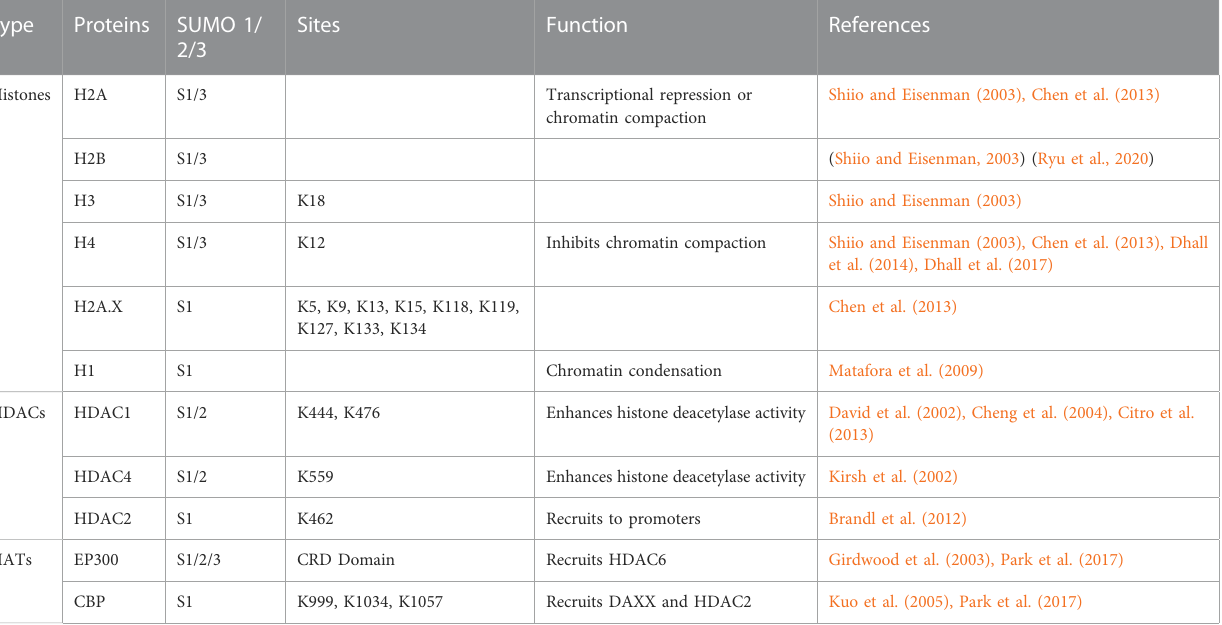
TABLE 1 SUMOylation of histones, HATs and